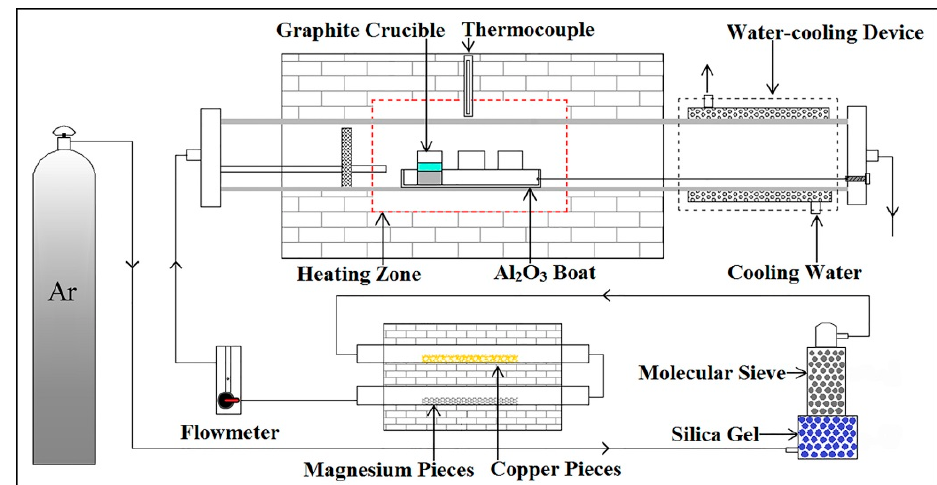
Figure 2. Schematic diagram of the experimental device. Table 1. Experimental data after